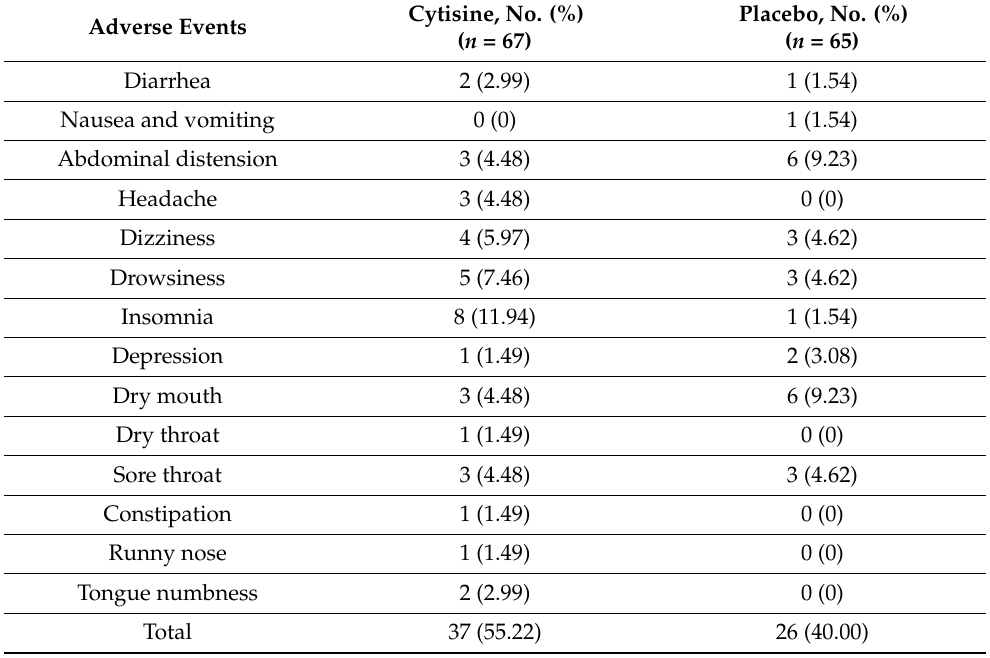
Table 4. The rate of adverse events between the cytisine group and the placebo group. Adverse Events